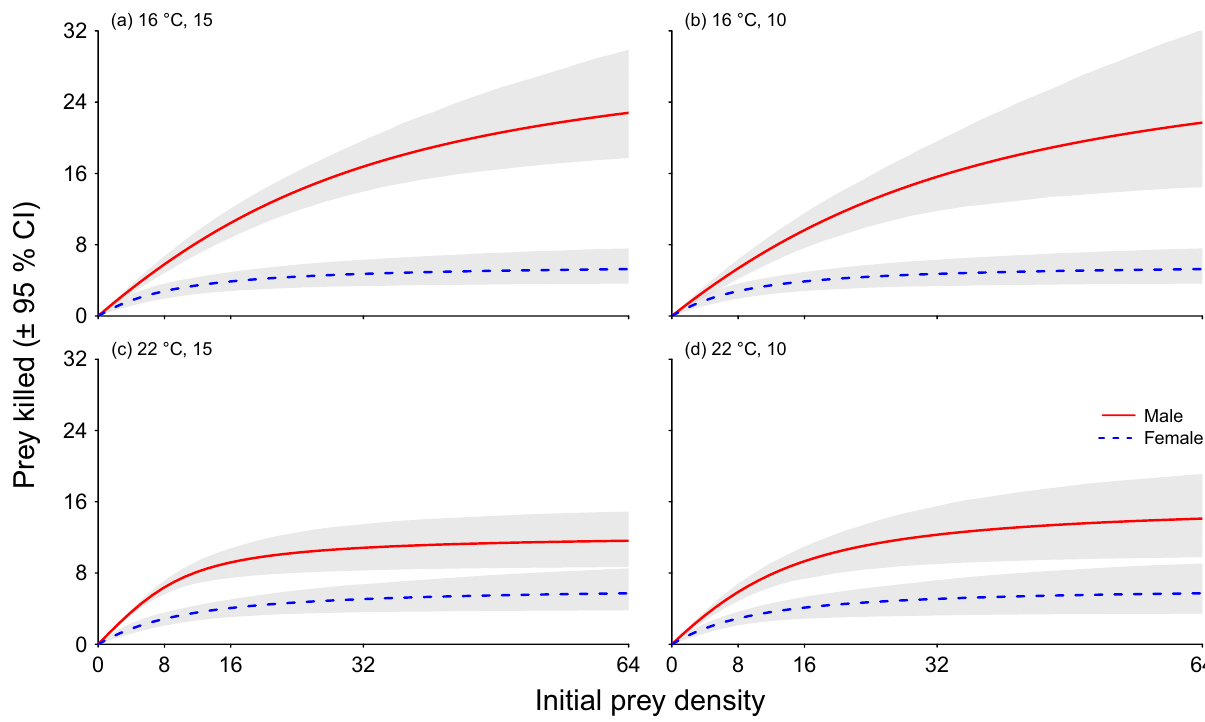
Figure 3. Functional response curves for male and female Hemigrapsus takanoi preying upon Mytilus edulis under four different abiotic conditions: ( a ) ambient salinity and ambient temperature, ( b ) desalination and ambient temperature, ( c ) ambient salinity and warming, ( d ) desalination and warming. Shaded areas represent bootstrapped (n = 2000) 95% confidence intervals. Lines represent the functional response model (Type II curves for all treatment